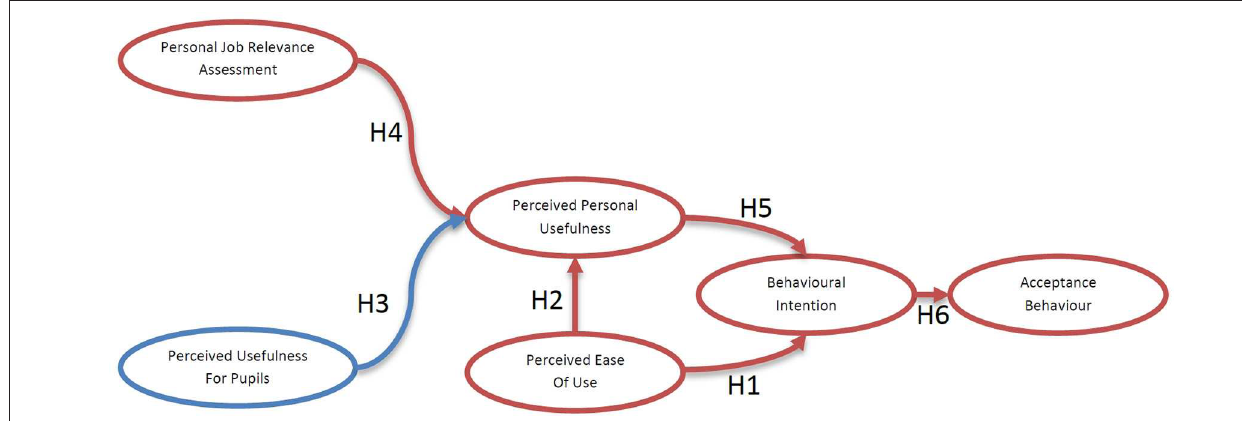
FIGURE 2 | Conceptual model of the adapted UTAUT model.